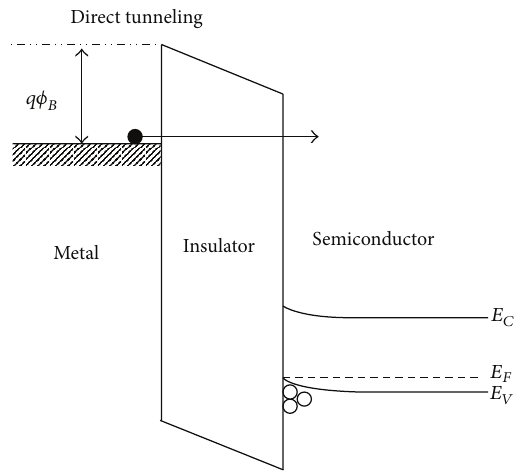
Figure 8: Schematic energy band diagram of direct tunneling in metal-insulator-semiconductor